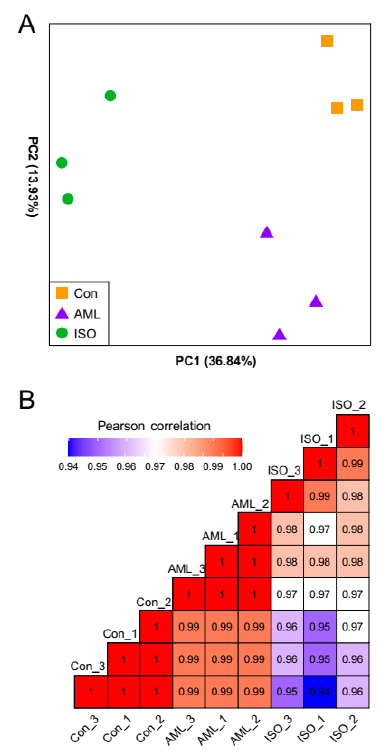
Figure 1. Transcriptome profile results. Principal component analysis (PCA) of transcriptome of all 9 RNAseq libraries ( A ) and sample-wise Pearson correlation of all transcriptome data ( B ). The percentages of the total variation that are accounted for by the first two principal components are 36.84% and 13.93% respectively. Symbols represent samples and are colored according to different exposure treatments: yellow box (Con: wide type control), purple triangle (AML exposure group), and green circle (isoflucypram exposure